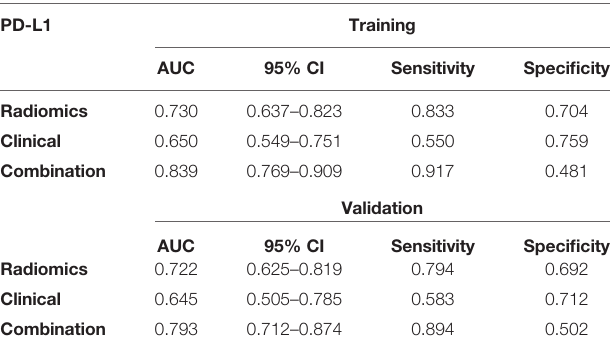
TABLE 5 | The predictive performance of the radiomics model, the clinical model, and the combined model for predicting PD-L1 expression levels in the training and validation sets.